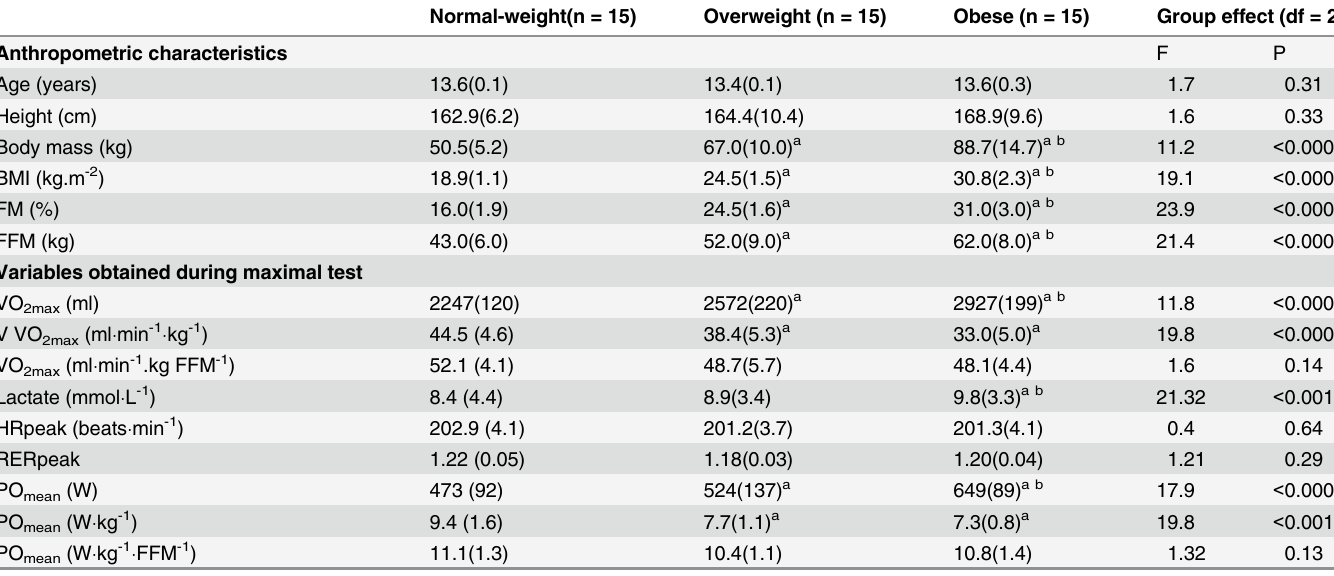
Table 1. Physiological characteristics.